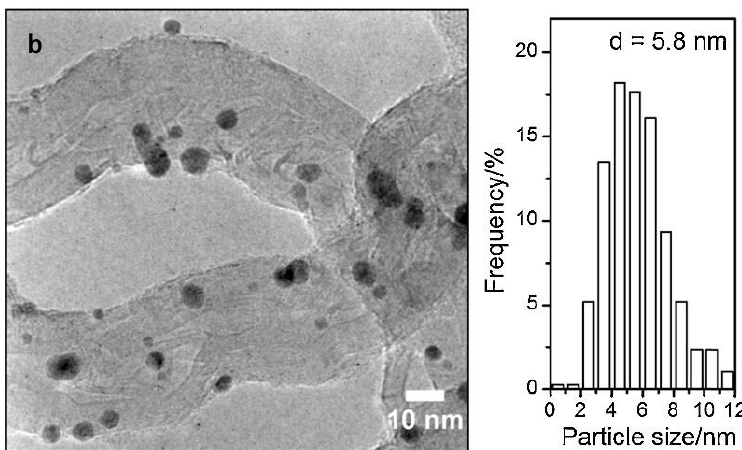
Figure 3. ( a ) HR-TEM image of an Au/Al 2 O 3 catalyst prepared by incipient wetness impregnation, reduced at 250 °C using 5% (vol.) of hydrogen in nitrogen as gas phase. ( b ) HR-TEM image and respective histogram of gold particle size distribution of Au/CNT prepared by vapor-phase deposition (dried overnight at 90 °C). Gold nanoparticles are seen as dark spots. Adapted from Baatz et al. [87] and Lorençon et al. [88], respectively.